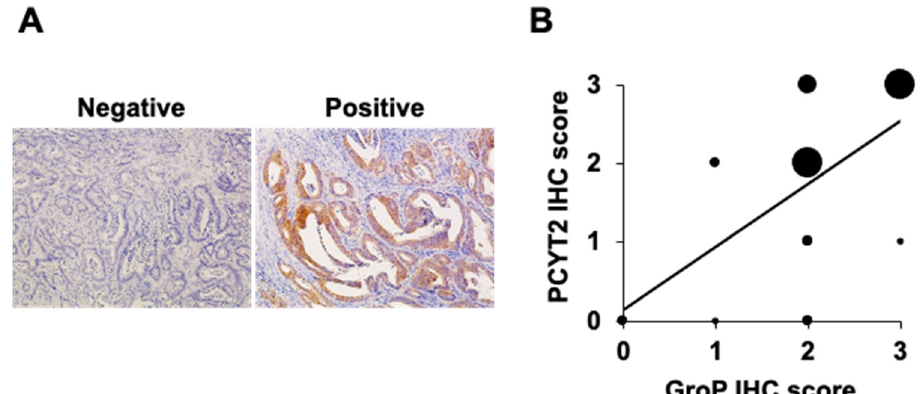
Figure 7. Correlation between GroP modification and PCYT2 expression levels in colorectal cancer tissues. ( A ) Representative images of PCYT2 staining. The left and right panels represent negative PCYT2 and positive PCYT2 staining, respectively, in human colorectal cancer tissues (×100). ( B ) Mapping of correlation between GroP modification and PCYT2 expression levels based on the staining scores. Staining scores of both GroP and PCYT2 were calculated at stage IV colorectal cancer tissues, and data were analyzed using the Spearman rank correlation. Dot size corresponds to the number of colorectal cancer tissue samples.